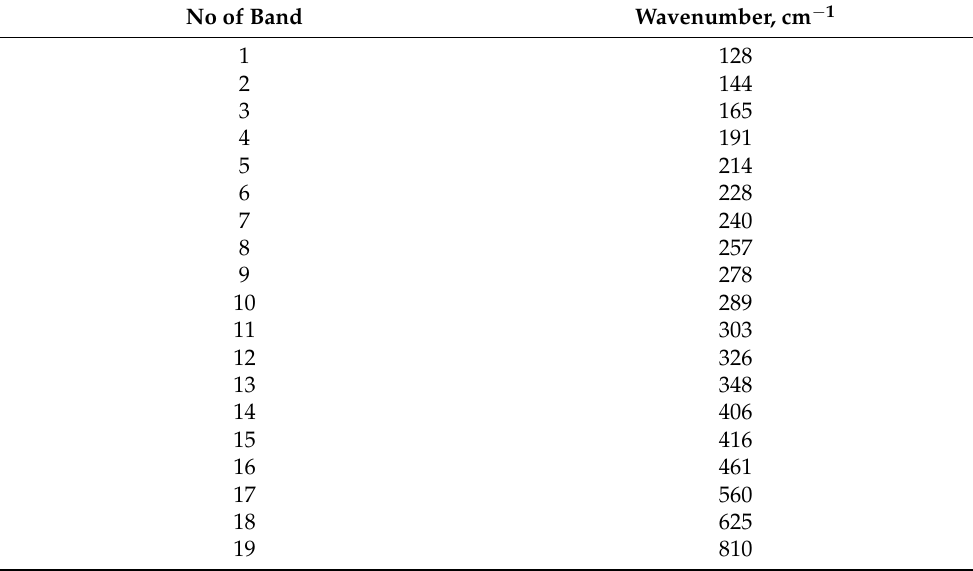
Table 2. Wavenumbers (cm − 1 ) of Raman bands for the SrLa 2 Sc 2 O 7 compound. No of Band Wavenumber, cm − 1